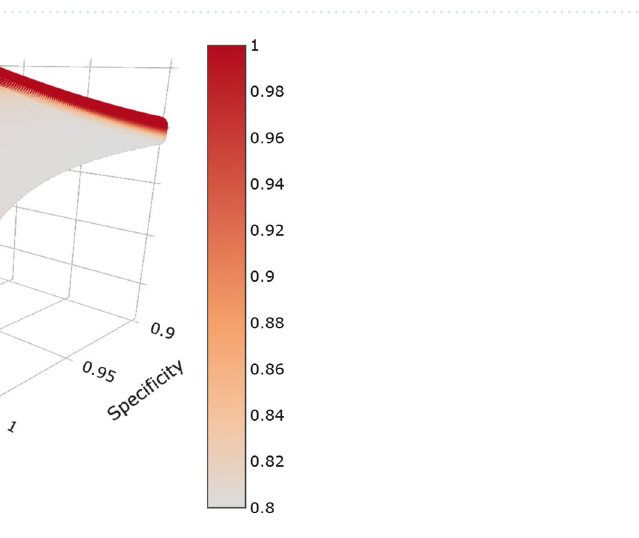
Figure 2. Plot of PPV by prevalence (0.01–0.3), specificity (0.9–1), and sensitivity (0.8–1). Sensitivity is denoted by color, with lighter colors denoting low sensitivity and darker colors denoting higher sensitivity. All parameters are reported as decimals ranging from 0 to 1. PPV varied widely based on different parameters, ranging from 0.07 to